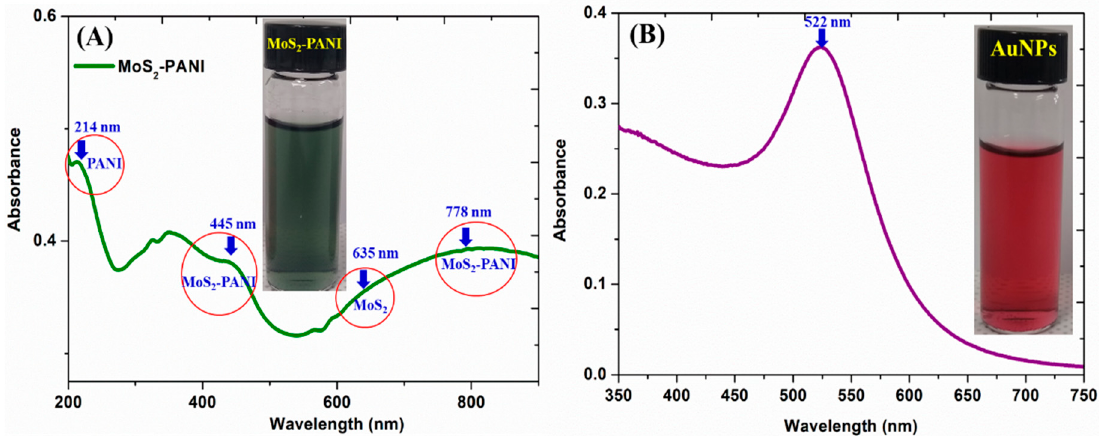
Figure 2. ( A ) UV–visible absorption spectra of MoS 2 –PANI nanocomposite dispersed in water, and inset showing a photograph of the MoS 2 –PANI composite; ( B ) UV–visible absorption spectra of AuNPs, and inset showing a photograph of the AuNP solution.